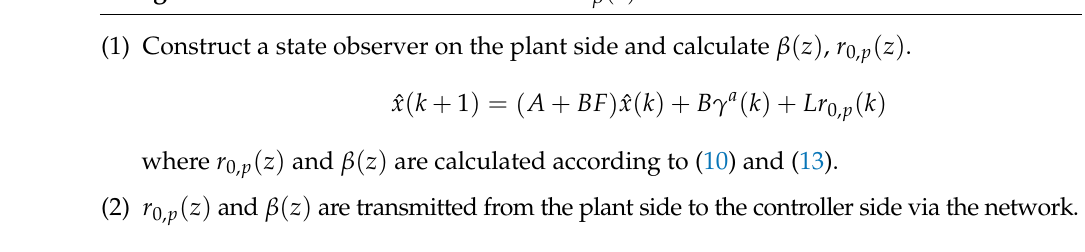
Algorithm 1: Detection Process Based on r β ( z )